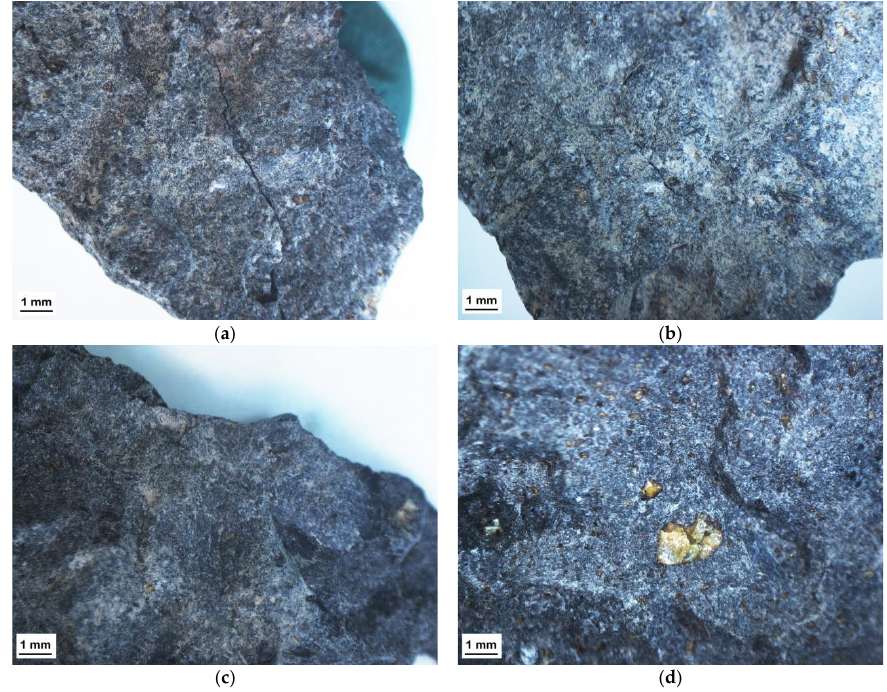
Figure A10. Characteristics of cracks in samples after crushing in jaw crusher (feed — non-flaky grains): ( a ) Basalt aggregate 2, non-flaky grains, +8 mm; ( b ) Basalt aggregate 2, non-flaky grains, +16 mm; ( c ) Basalt aggregate 2, flaky grains, +8 mm; ( d ) Basalt aggregate 2, flaky grains, +16 mm.